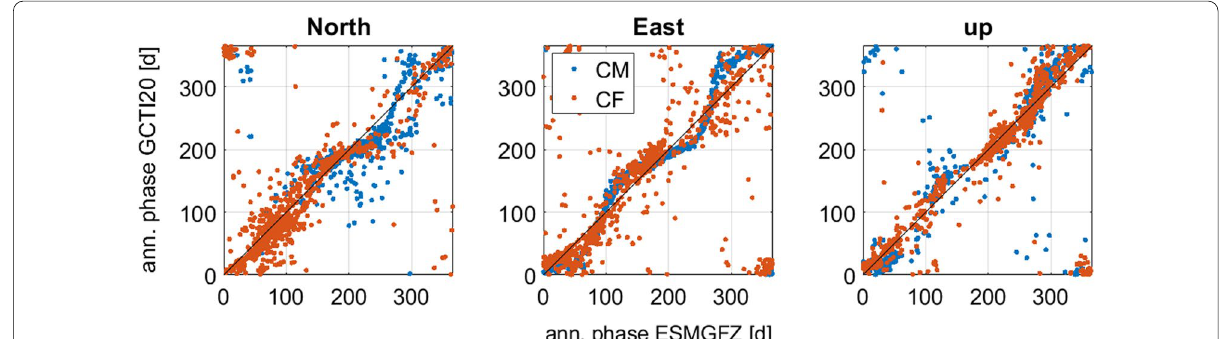
Fig. 13 Fitted annual (ann.) phases in days for the combined (NTAL of GCTI20 (y-axes). Blue dots refer to the CM-frame displacements, and red dots represent the CF-frame